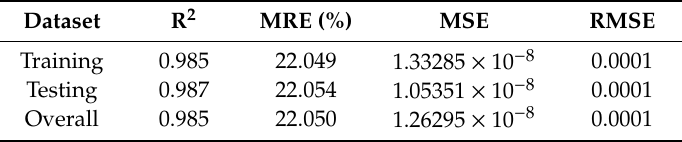
Table 2. Statistical analyses of developed model.